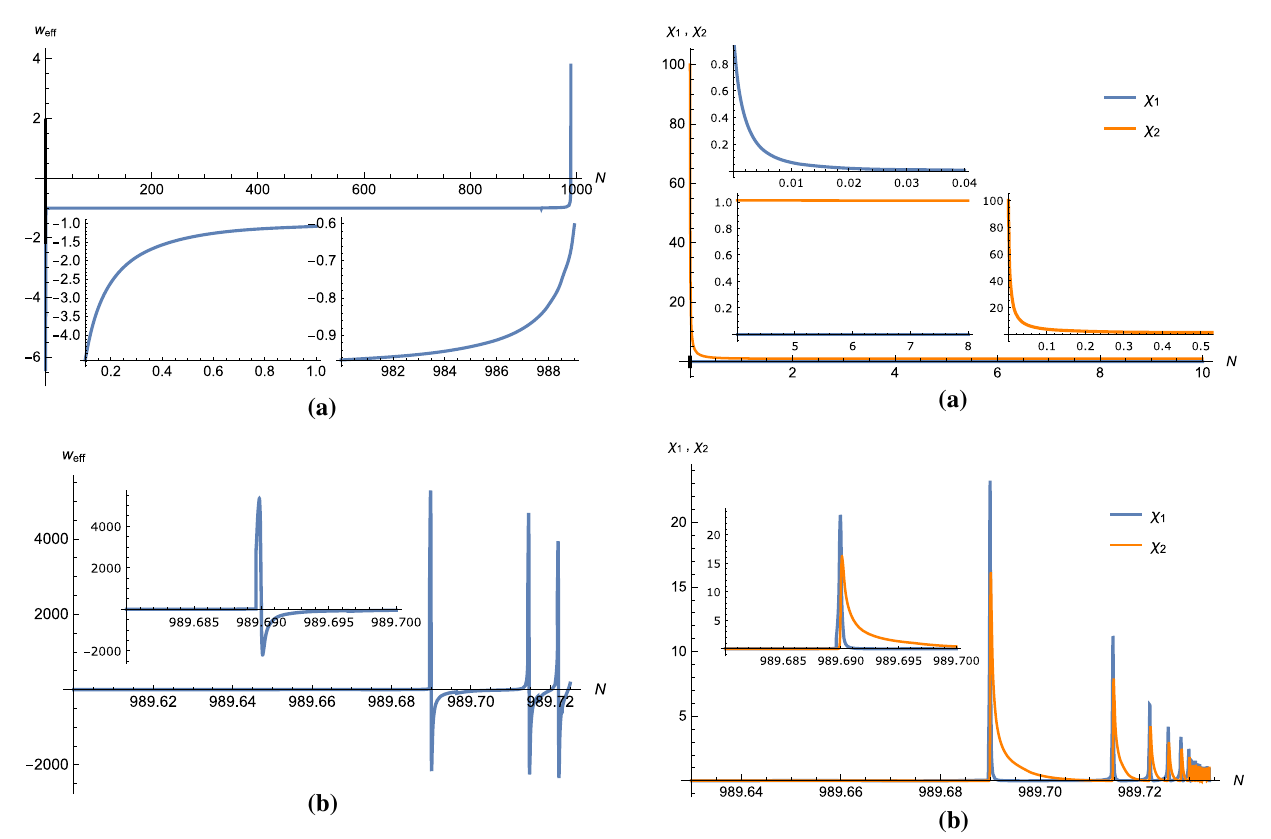
Fig. 6 Both the above plots have been taken from one numerical sim- ulation but for different ranges of N . This simulation has been initiated with χ 1 ( N = 0 ) = 1 and χ 2 ( N = 0 ) = 100 with ξ = 400, M p = 1 and λ = 1. This set of initial conditions along with the parameters choice corresponds to w ef f [ N = 0 ] ≈ − 127. a The phantom energy exponentially increases toward de Sitter ( w ef f = − 1). This part of the simulation confirms that de Sitter is a transient attractor path for phan- tom originated trajectories. As one recognizes, the deeper in the phan- tom region, the faster (less e-folds) motion toward de Sitter attractor. b w ef f asymptotically approaches the de Sitter expansion for enough e-folds before encountering the oscillations. As it is shown in Fig. 3 the average w ef f for each complete oscillation is about 1 / 3